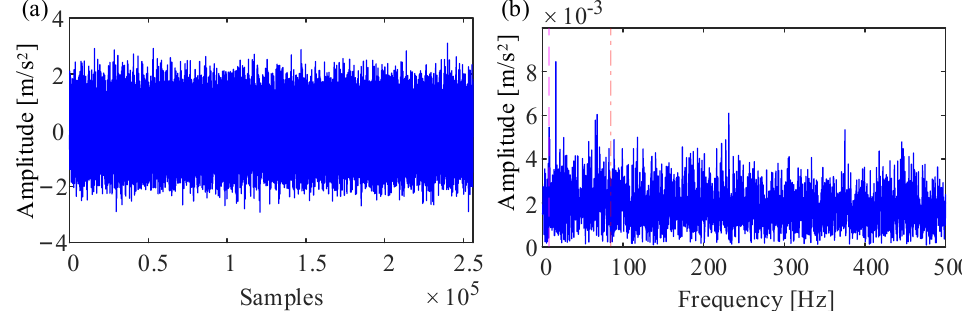
Figure 10. Test results at 500 rpm: ( a ) raw signal; ( b ) envelope spectrum, dash-dotted line with red: the fault frequency; dotted line with purple: the rotor frequency.